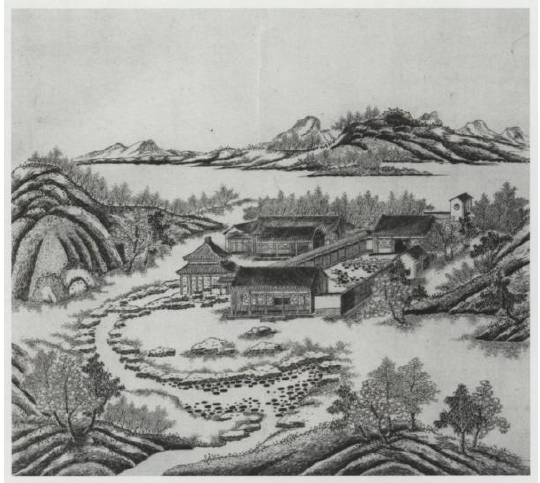
Figure 4. Xiang yuan yi qing , drawn by a Chinese artist and engraved by Father Matteo Ripa (1682-1746) in 1713.